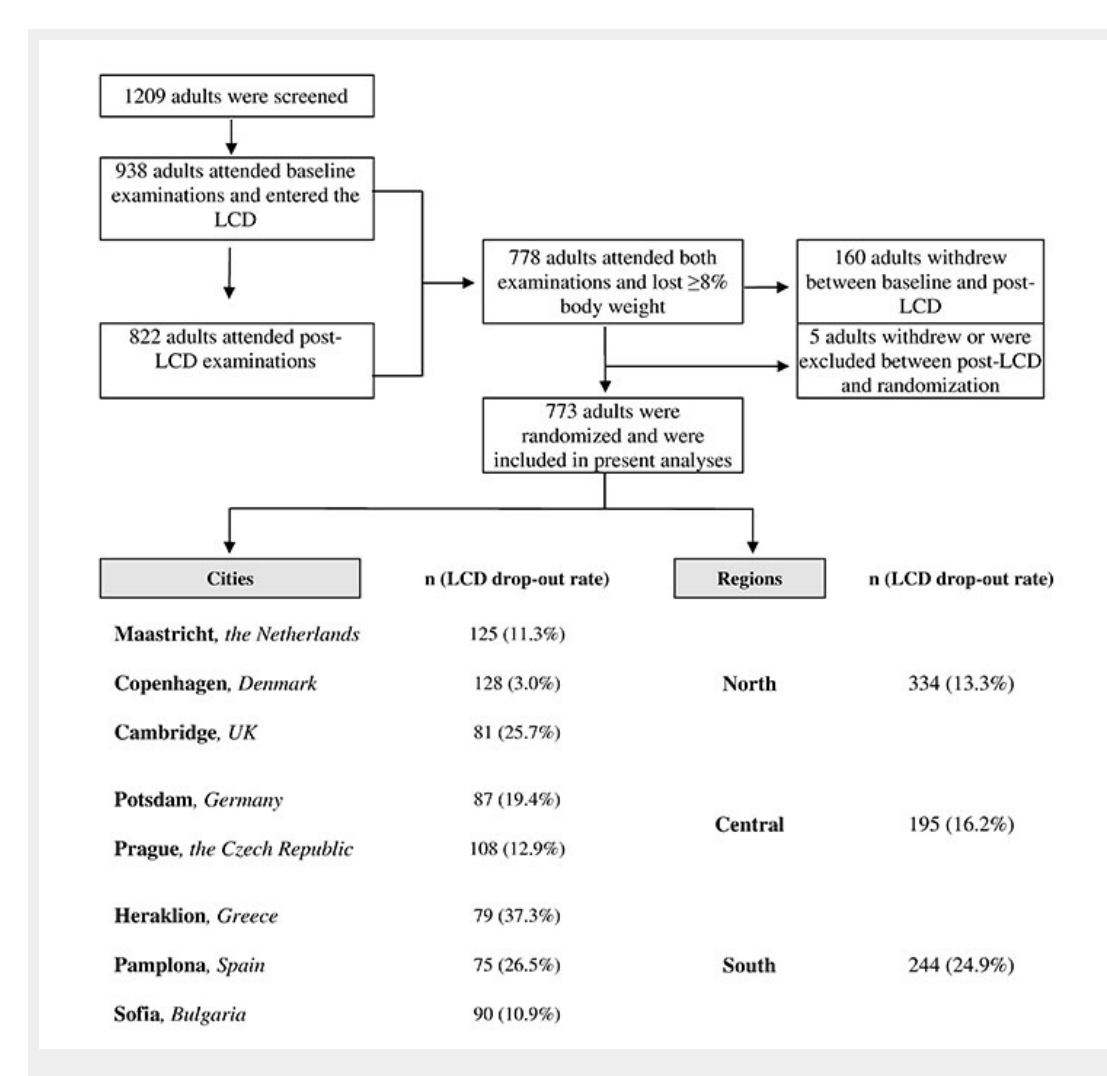
Figure 1 Flow diagram showing progress of the DiOGenes participants from screening to post-LCD,